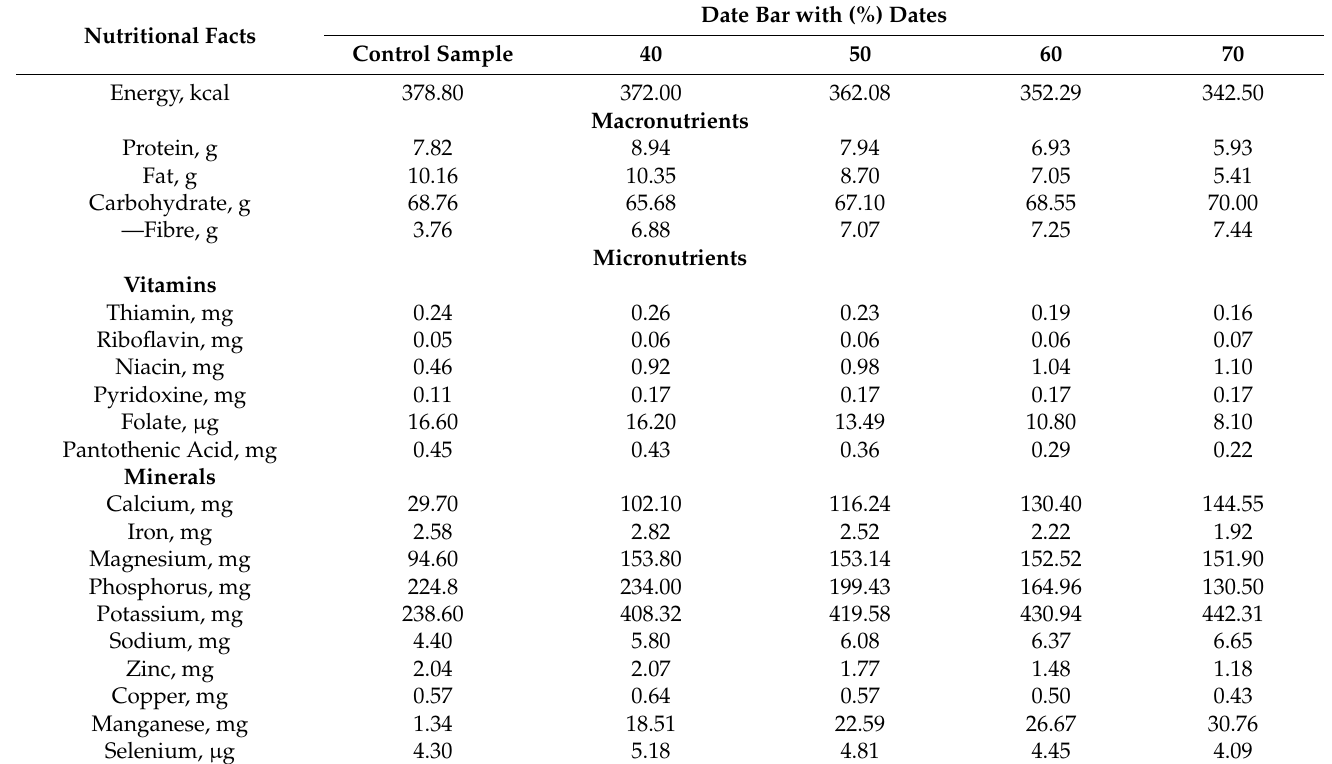
Table 2. Nutritional facts about the samples of snack bars with date